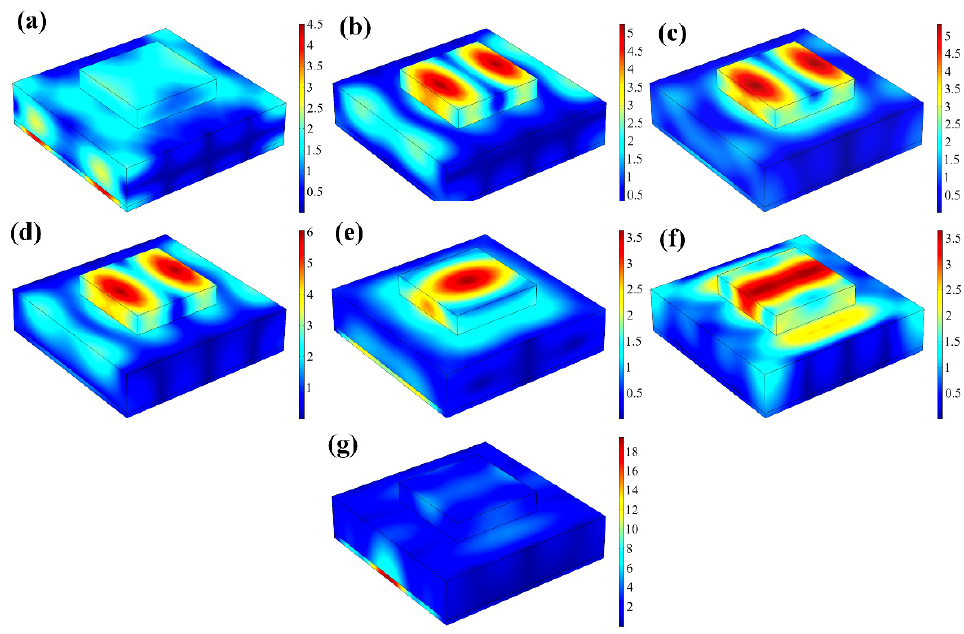
Figure 9. Variation electric field intensity for the different values of the refractive index of sample analyte material and incident frequency. Normalized electric field intensity E (V/m) for ( a ) n = 1.1, ω = 180 THz, ( b ) n = 1.2, ω = 221 THz, ( c ) n = 1.3, ω = 204 THz, ( d ) n = 1.4, ω = 208 THz, ( e ) n = 1.5, ω = 240 THz, ( f ) n = 1.6, ω = 193 THz, ( g ) n = 1.7, ω = 183 THz.